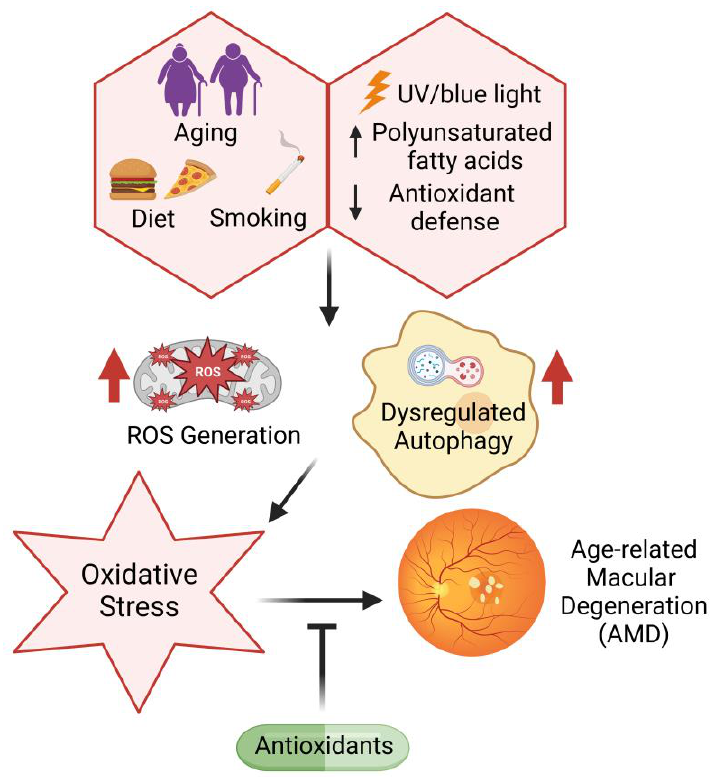
Figure 2. Factors driving oxidative damage during age-related macular degeneration (AMD) and the need for antioxidant defense systems to combat the pathophysiology of the disease.